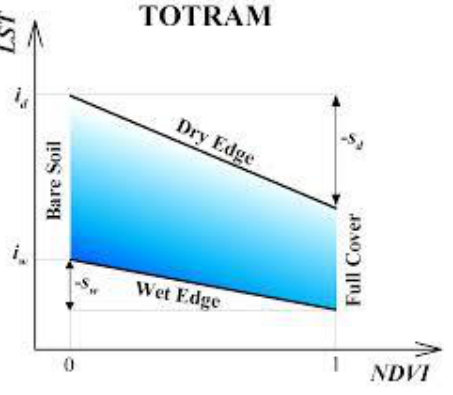
Figure 4. Thermal Optical Trapezoid Model.